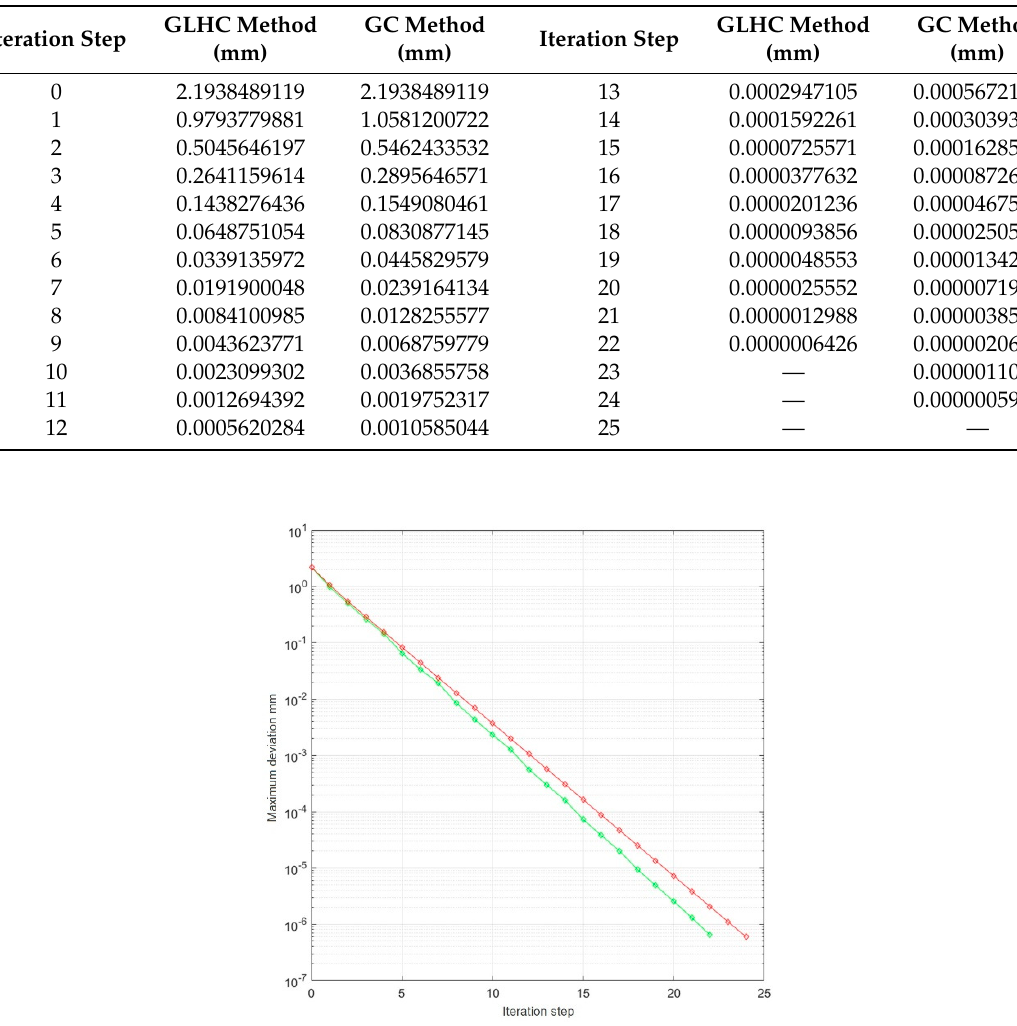
Table 3. The maximum deviations in each iteration step.